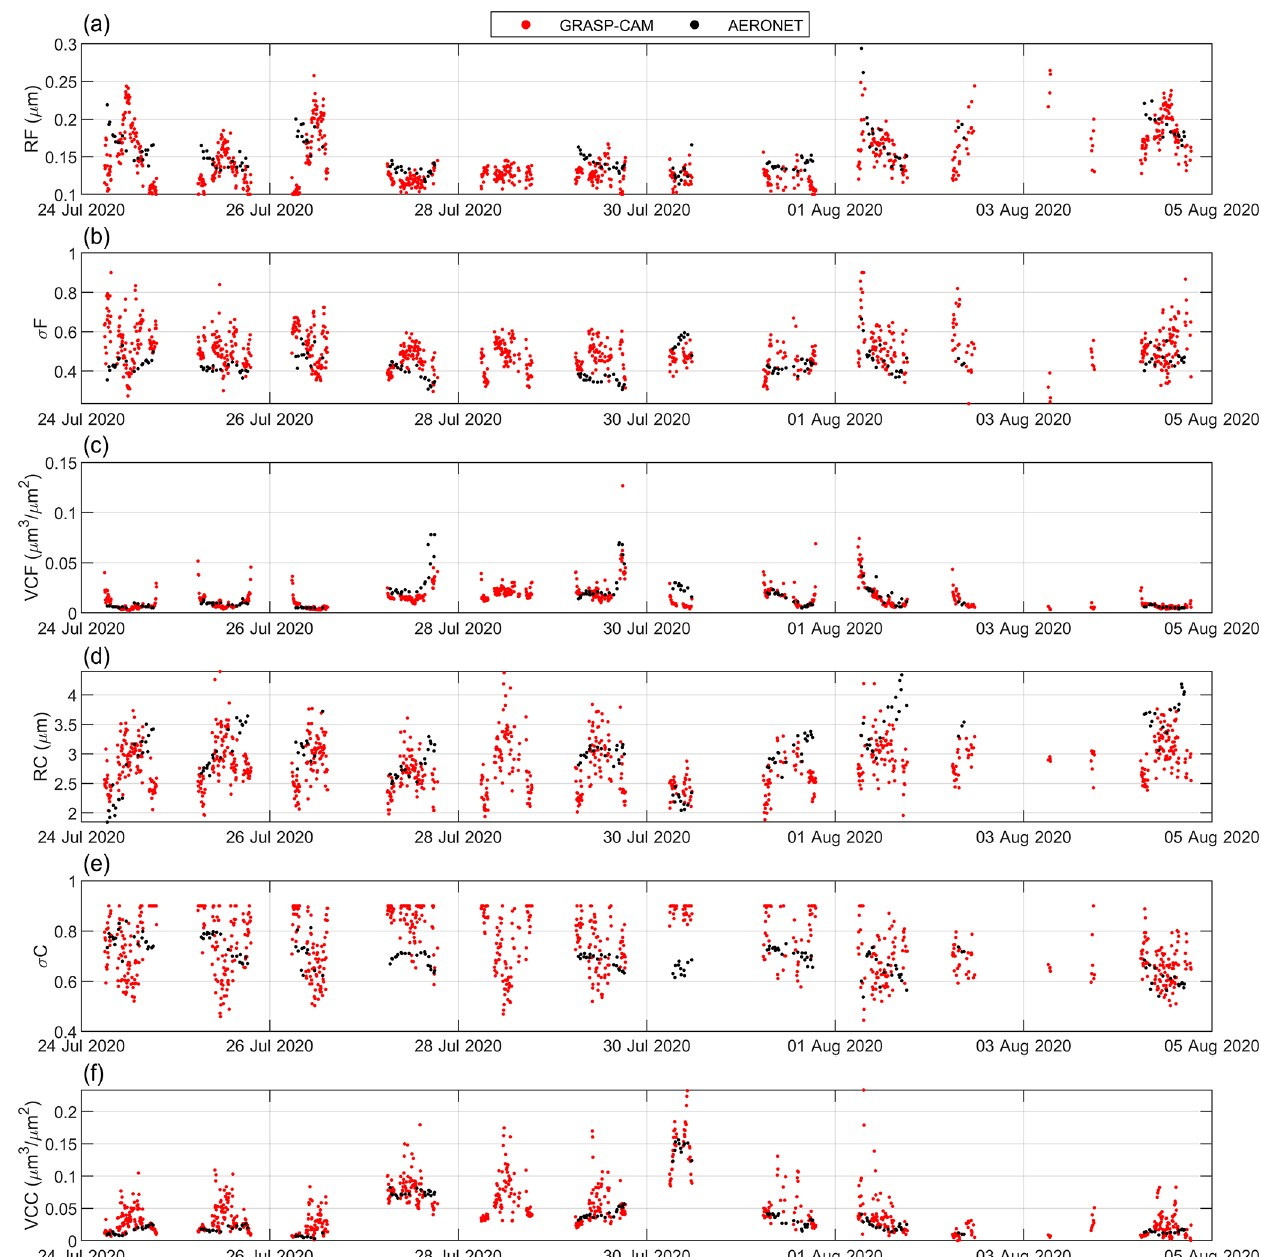
Figure 12. Volume median radius, R , standard deviation of log-normal distribution, σ , and aerosol volume concentration, VC, for fine (F; a–c ) and coarse (C; d–f ) modes of the aerosol size distribution retrieved by GRASP with the single-pixel approach (GRASP-CAM) and by AERONET at Valladolid from 24 July to 4 August